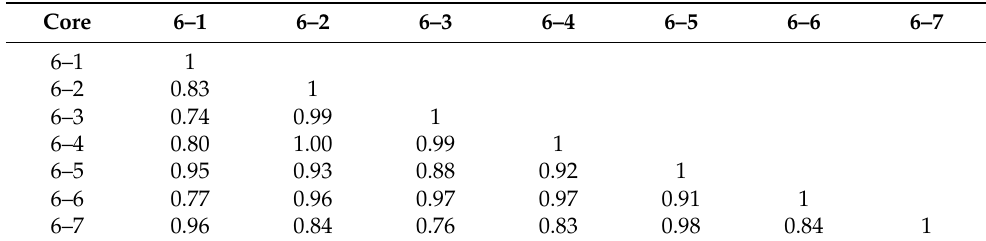
Table 2. The cross-correlation coefficients of all cores appear in Table 1.